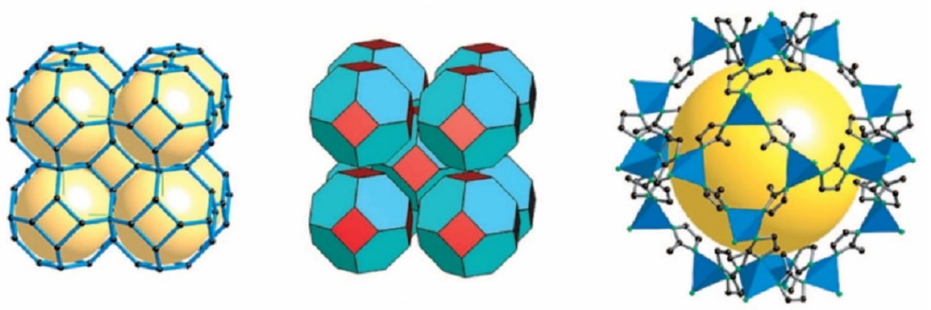
Figure 5. Crystal structure and simplified framework structures of ZIF-8 (Zn(2-methylimidazolate) 2 . Reproduced with permission from ref. [73]. Copyright © 2006 National Academy of Sciences of the